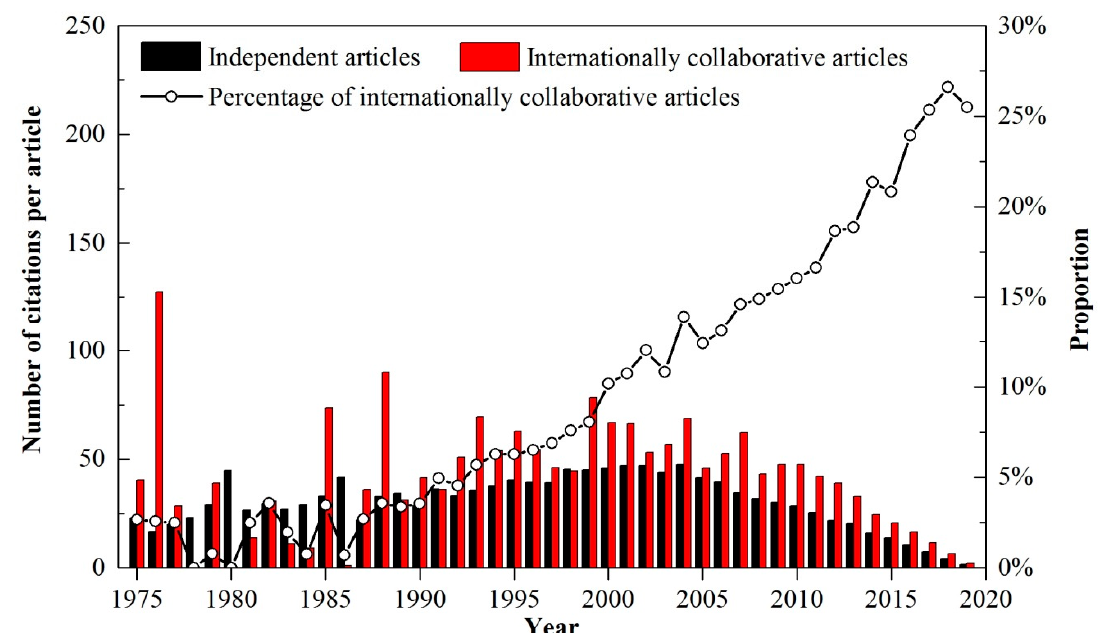
Figure 3. Evolution of internationally collaborative and independent articles in SW research